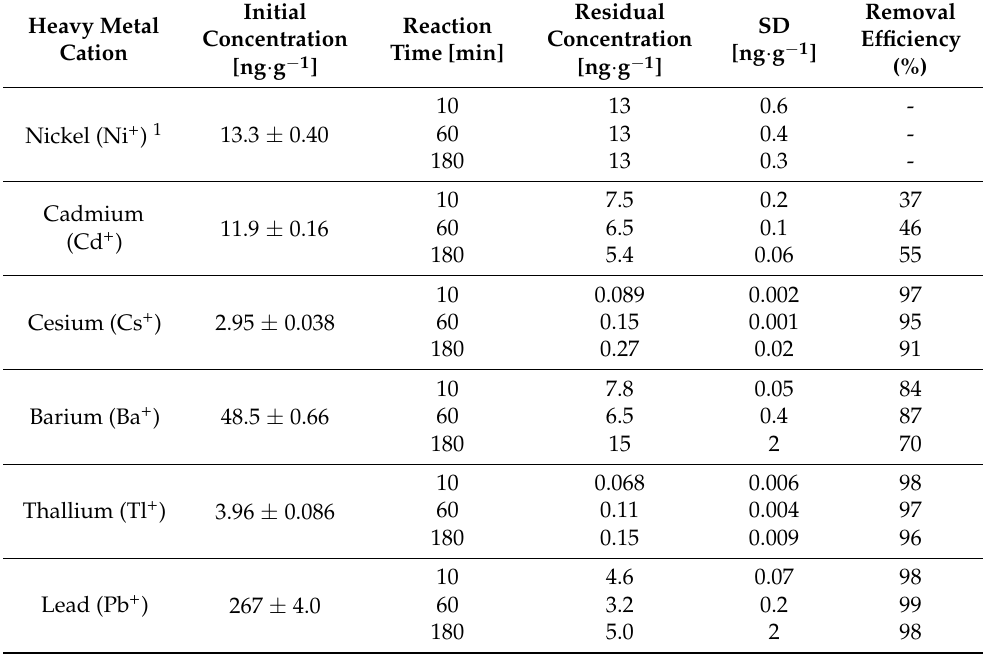
Table 11. Adsorption kinetics of different heavy metal cations from heavy-metal-contaminated non-carbonated mineral water onto